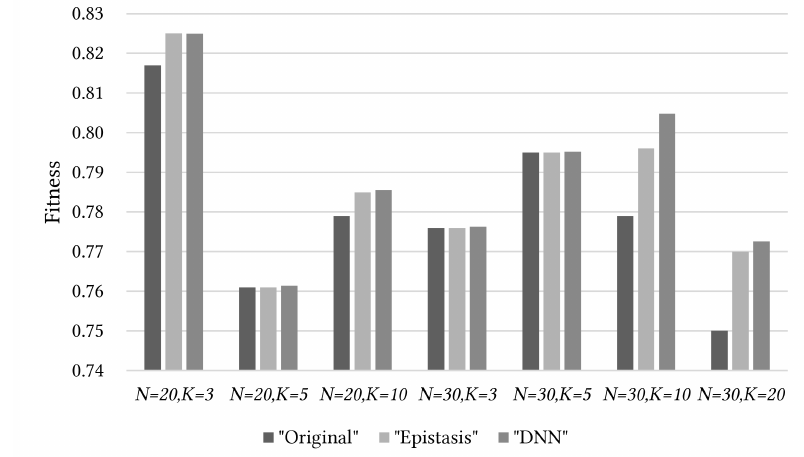
Figure 7. Comparison of best solution results for the experiments in this study (“DNN”) and previous studies (“Original” and “Epistasis”) on the NK -landscape